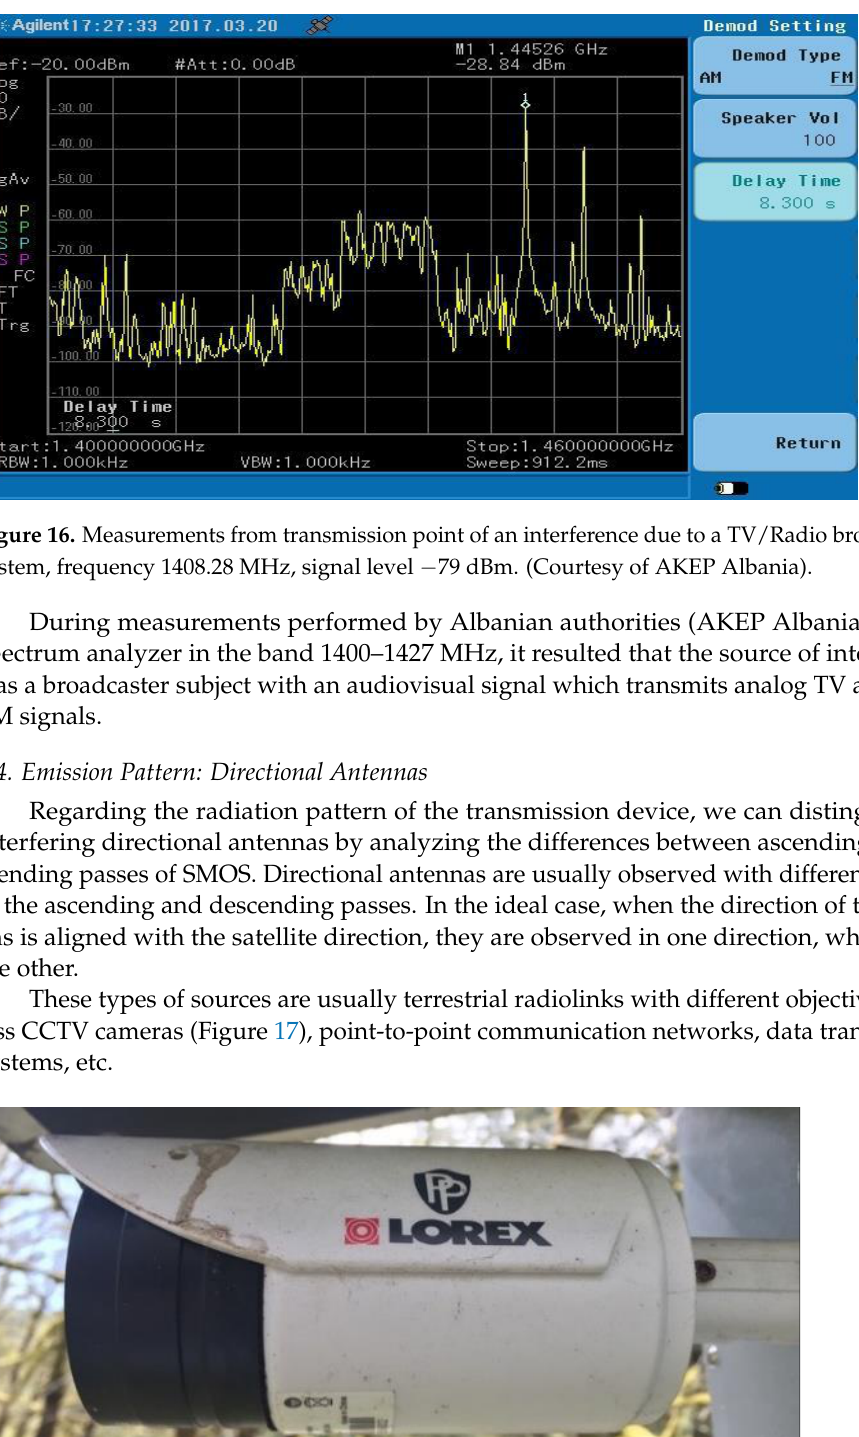
Figure 17. Detected interfering wireless audio/video transmitter used as part of a CCTV camera system (courtesy of FCC United States).